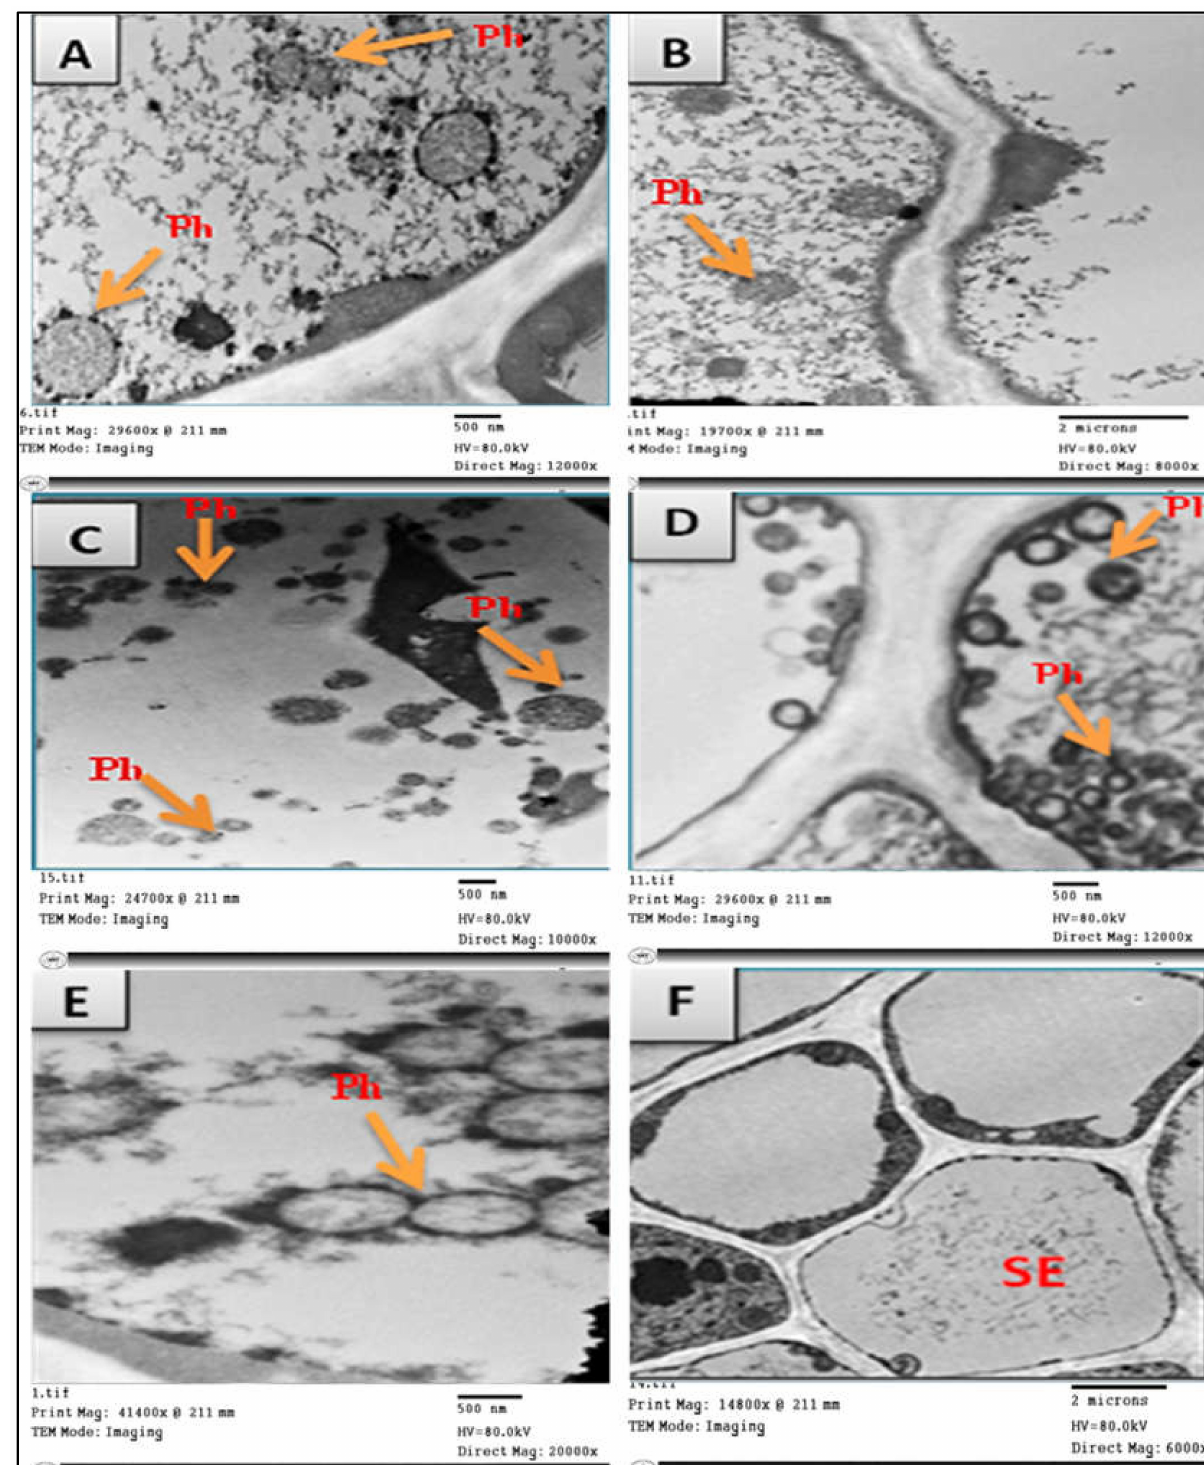
Figure 5. Transmission electron micrograph of sieve elements of phytoplasma-infected faba bean showing the effect of plants treated with boric acid (BA-NPs), salicylic acid (SA-NPs), and glycyrrhizic acid (GAS-NPs) nanoparticles on phytoplasma units at the best concentrations of 0.124, 0.28, and 1.68 µ M ( A – C ), respectively, compared with phytoplasma controls ( D , E ) and healthy controls ( F ). Ph = Phytoplasma, SE = sieve